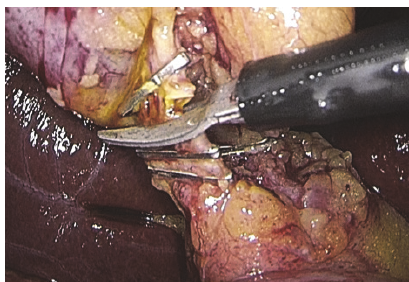
Figure 7: Cystic duct complete